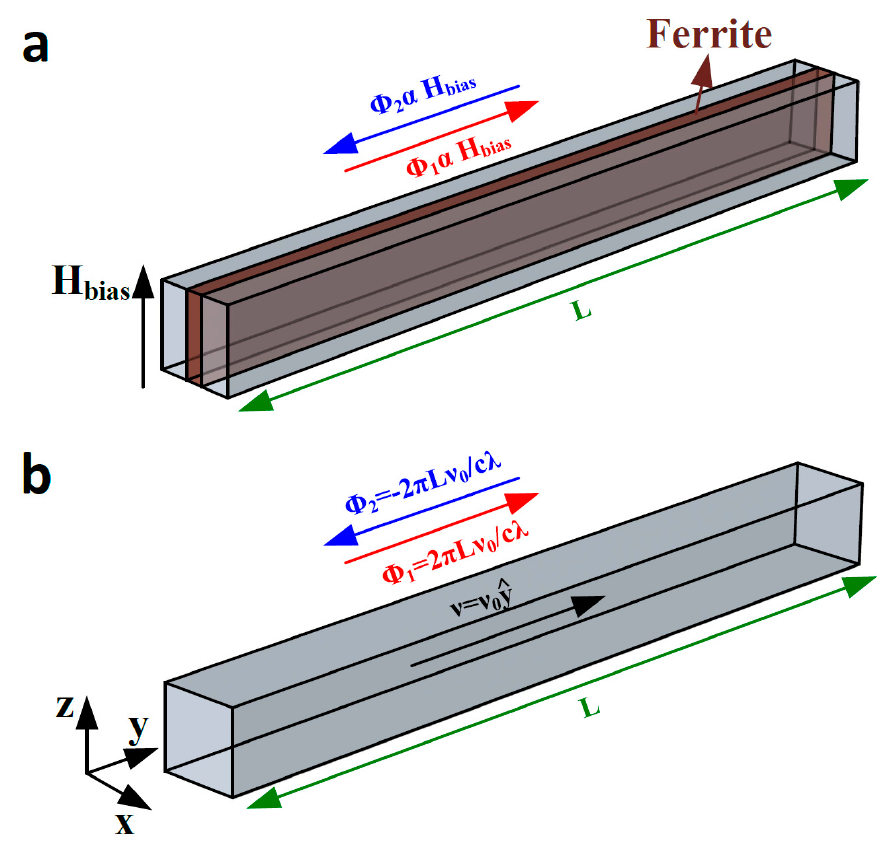
Figure 1. Concept of non-reciprocal phase shifters. ( a ) Schematic of a typical non-reciprocal phase shifter in microwave engineering. The device is composed of a waveguide that is partially filled with a ferrite slab on which a constant magnetic bias field is applied. The amount of differential phase shift between the forward and backward waves can be controlled by changing the magnetic field. ( b ) Acoustic equivalent of the microwave phase shifter shown in panel a. The structure consists of an acoustic waveguide that is filled with a fluid on which a velocity motion of ν 0 is applied. The waveguide provides different phase shifts of ϕ 1 and ϕ 2 for forward and backward transmission, respectively.